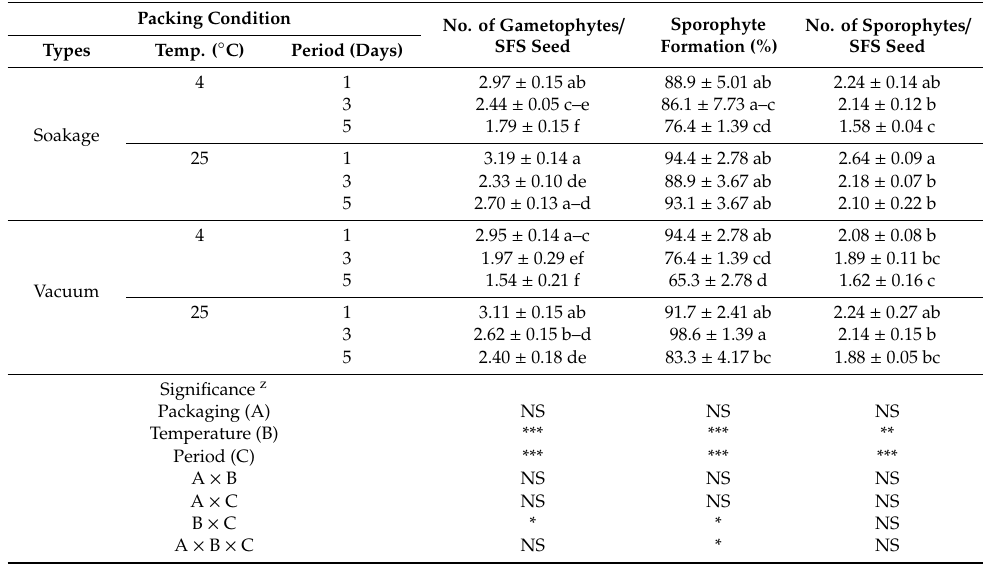
Table 5. E ff ect of packing conditions for short-term storage and transport on gametophyte and sporophyte formation from bracken SFS (synthetic seeds using fern